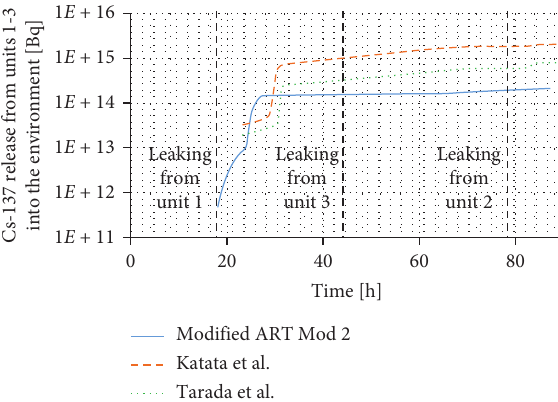
Figure 11: Total accumulative release of Cs-137 into the environment from Units 1–3 of the first case.